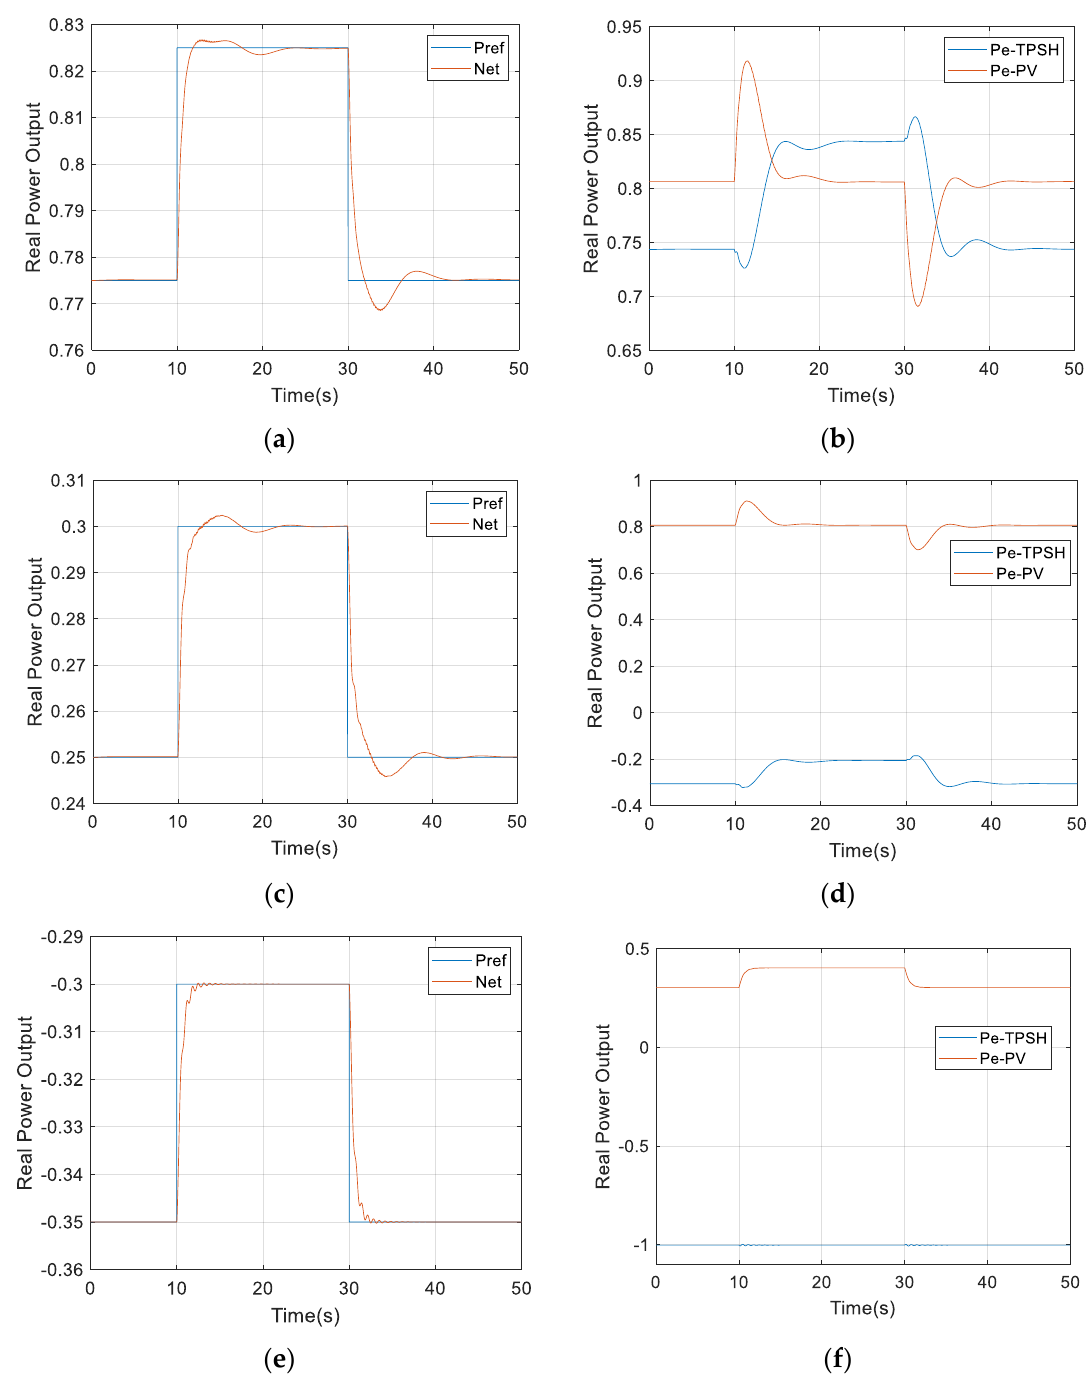
Figure 9. Set-point tracking capability and individual power output of the PV and TPSH plant in ( a , b ) generation mode, ( c , d ) pump mode with hydraulic short-circuit, ( e , f ) pure pump mode.